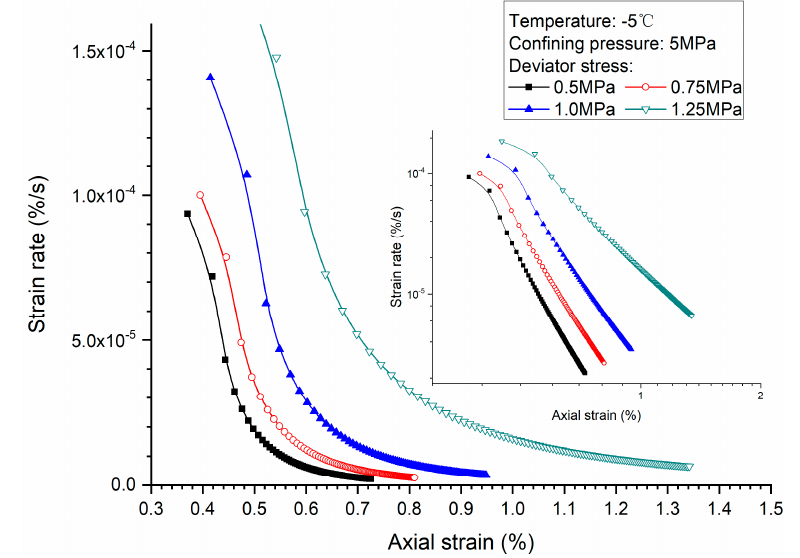
Figure 4. Creep strain rate versus axial strain for methane hydrate-bearing frozen specimens under low deviator stresses.